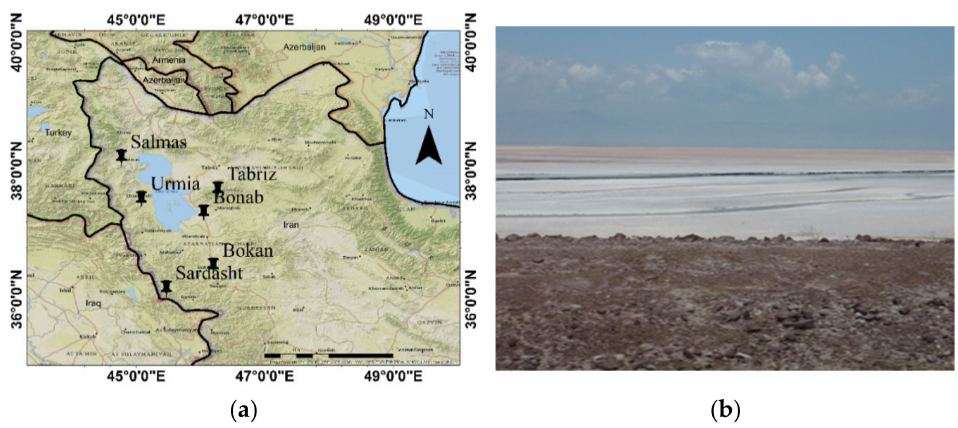
Figure 2. ( a ). The study area with some synoptic weather stations and air pollution monitoring stations (Salmas and Urmia stations located to the west of the lake, Bonab and Tabriz located to the east of the lake, and Bokan and Sardasht located to the south of the lake) in Urmia Lake area in NW Iran. ( b ). View of Lake Urmia from the Kalantari Highway, dividing the lake into two parts (photo C. Opp